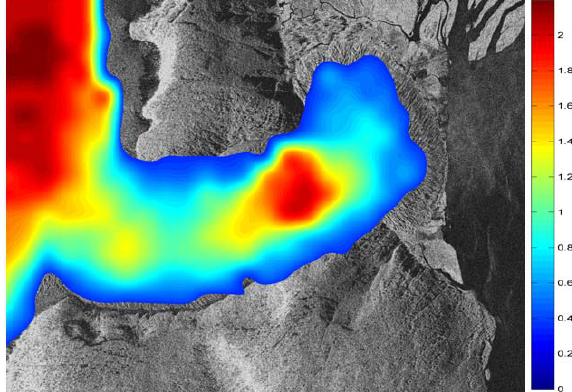
Fig.4. Fused estimated glacier velocity map plotted on the gray scale SAR image.